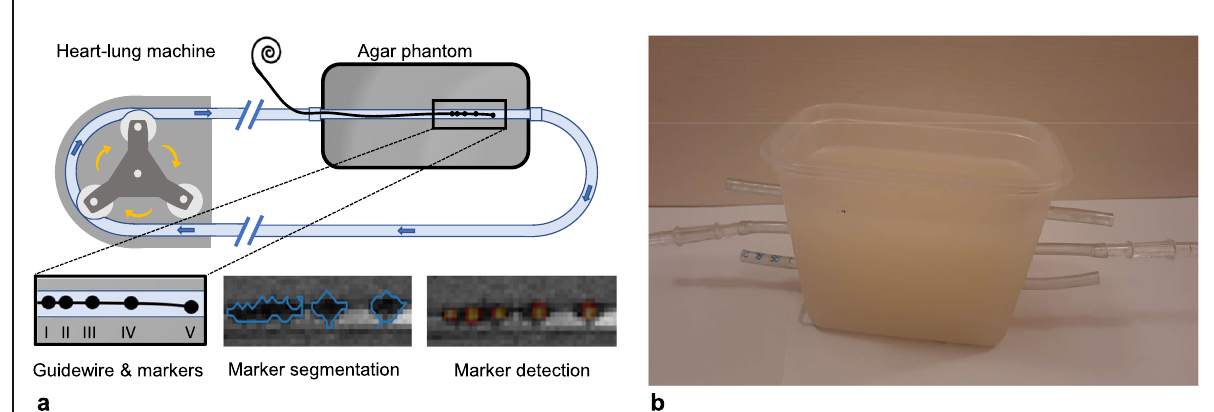
Fig. 1 a Schematic drawing of the guidewire with markers inserted in the flow phantom. Examples of segmented markers and automatically detected markers are visualised. b The phantom used for the experiments